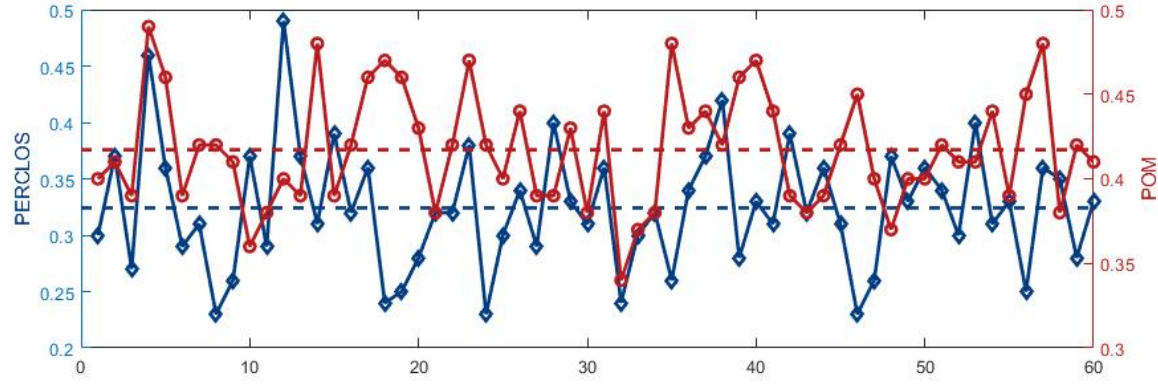
Figure 10. Threshold of PERCLOS and